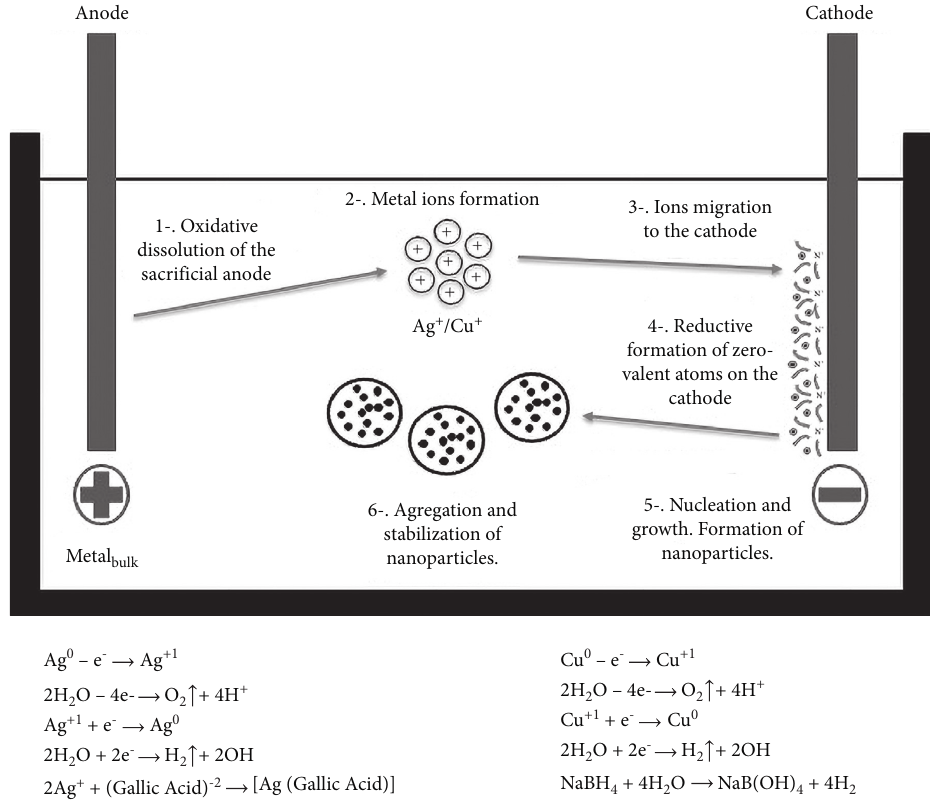
Figure 1: Electrochemical synthesis for the formation of nanoparticles